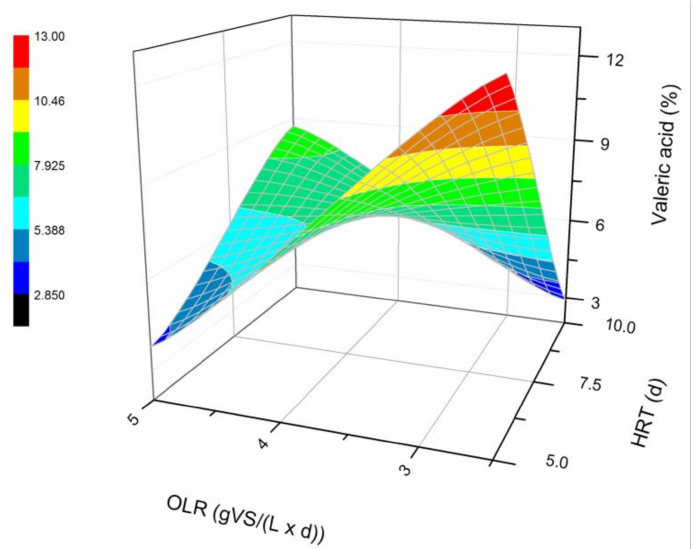
Figure 6. Changes in the content of valeric acid produced in a steady state during the DF process at the OLRs of 2.5 gVS/(L × d) and 5.0 gVS/(L × d) and the HRTs of 5 d and 10